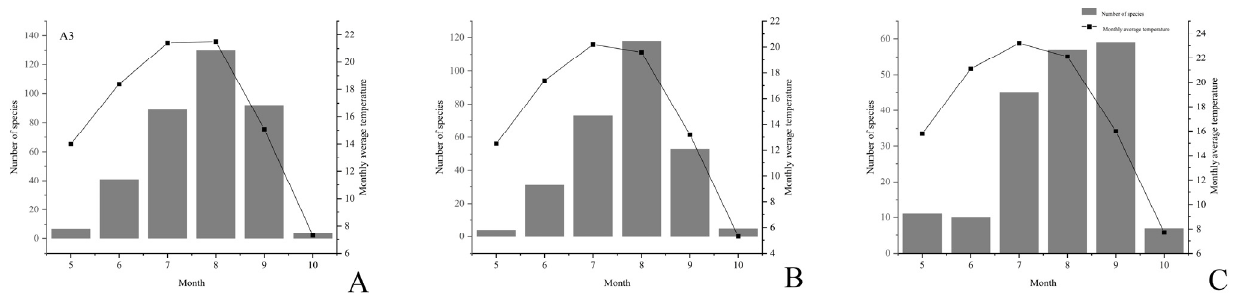
Figure 12. Effect of temperature on the occurrence of macrofungi in three different investigation sites from Jilin Province. ( A ) Quanshuidong Forest Farm; ( B ) Shengli River Forest Farm; ( C ) Jingyuetan National Forest Park.